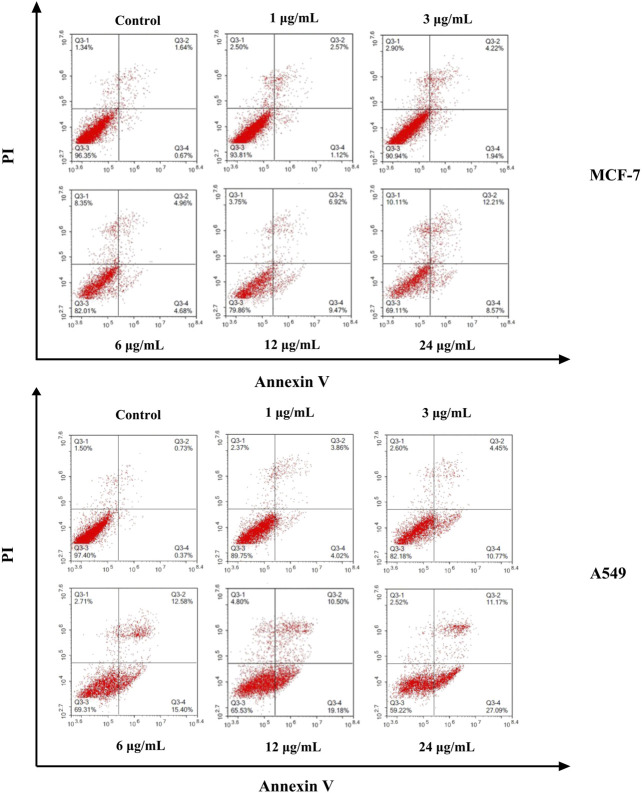
Flow cytometry analysis of MCF-7 and A549 cell apoptosis induced by different concentration of ODA10[(PW11Fe)2] for 24 h.